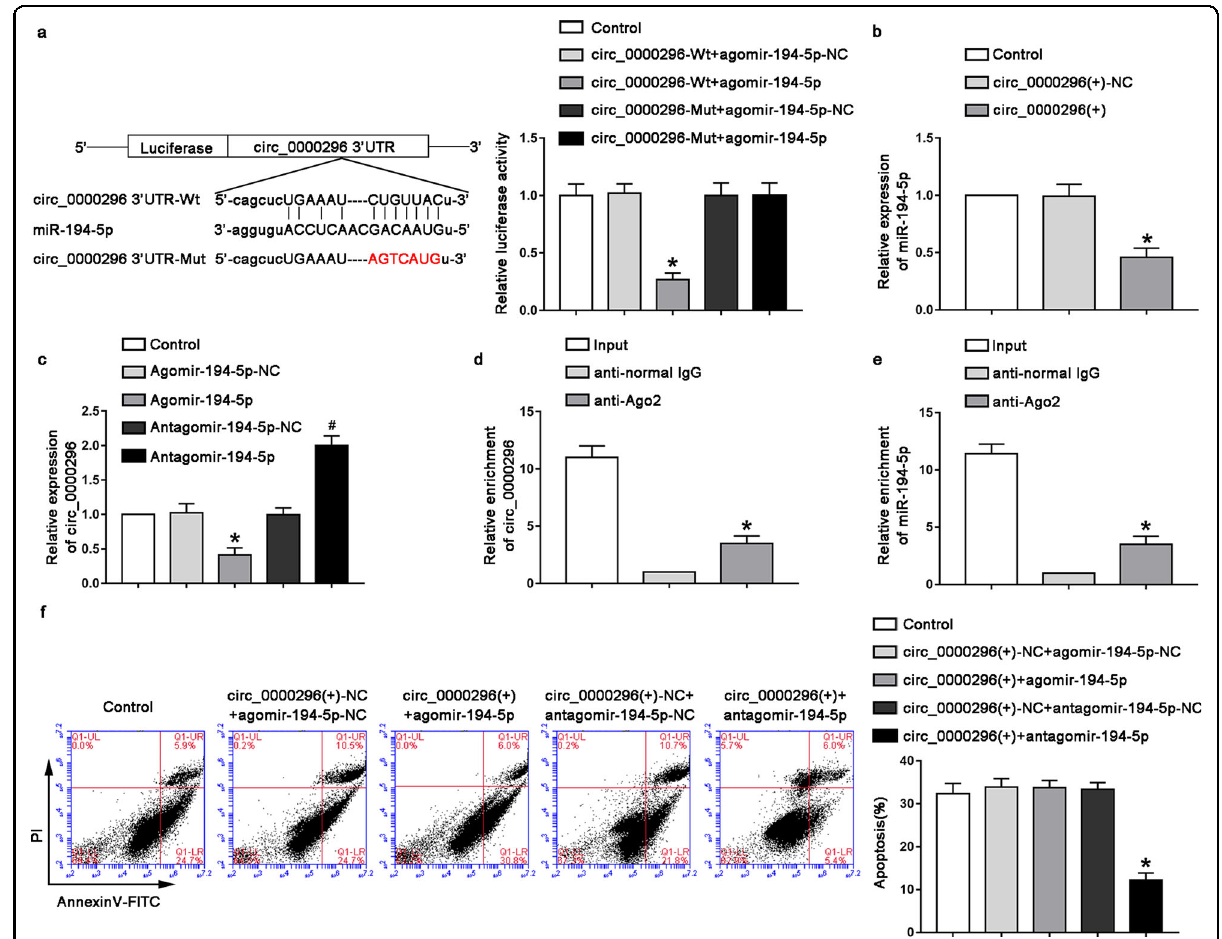
Fig. 2 miR-194-5p targetd circ_0000296 and reversed the effects of circ_0000296 on apoptosis of neuron in vitro. a The predicted miR-194- 5p-binding site in circ_0000296 (circ_0000296-Wt) and the designed mutant sequence (circ_0000296-Mut) were indicated. Dual-luciferase reporter assay of HT22 cells cotransfected with circ_0000296-Wt or circ_0000296-Mut and Agomir-194-5p or the Agomir-194-5p-NC. Data represented as mean ± SD. ( n = 5), * P < 0.05 vs. circ_0000296-Wt + agomir-194-5p-NC group. b Relative expression levels of miR-194-5p were measured by qRT-PCR after circ_0000296 overexpression Data represented as mean ± SD. ( n = 5), * P < 0.05 circ_0000296( + )-NC group c Relative expression levels of circ_0000296 were measured by qRT-PCR after miR-194-5p overexpression or knockdown. Data represented as mean ± SD. ( n = 5), * P < 0.05 vs. Agomir-194-5p-NC group. #P < 0.05 vs. Antagomir-194-5p-NC group. d , e miR-194-5p was identi fi ed in circ_0000296-RISC complex. Relative expression levels of circ_000029 and miR-194-5p were measured by qRT-PCR. Data represented as mean ± SD. ( n = 5, each group). * P < 0.05, vs. anti- normal IgG group. f Flow cytometry analysis of OGD-induced HT22 cells cotransfected with circ_0000296 and miR-194-5p with annexin V/PI staining. Data represented as mean ± SD. ( n = 3, each group) * P < 0.05 vs. circ_0000296( + )-NC +